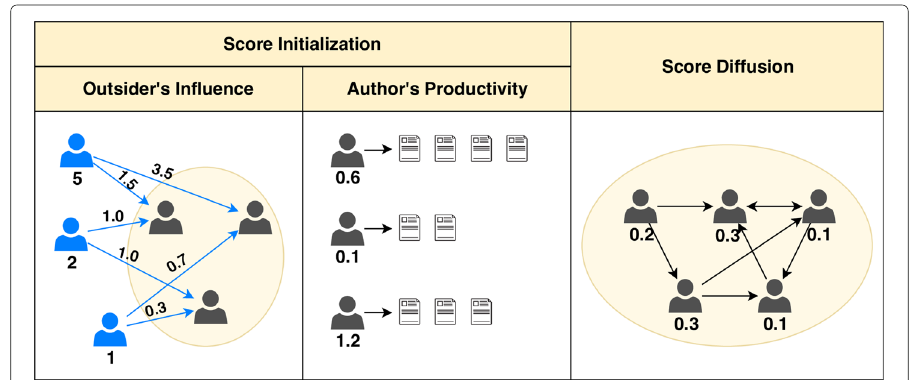
Fig. 3 Illustration of the three different feature categories used in OTARIOS to rank authors are considered better. In order to compare two ranks we use two ranking quality mea- sures: Normalized Discounted Cumulative Gain (NDCG) (Järvelin and Kekäläinen 2002) and Mean Reciprocal Rank (MRR) (Voorhees and et al. 1999). NDCG is a Discounted Cumulative Gain(DCG) based metric which divides the DCG of the predicted rank by the DCG of the ground truth (i.e., the perfect ranking). The idea of DCG is that highly rel- evant authors (from the ground truth) appearing lower in the predicted rank should be penalized using a logarithmic function (base 2) proportional to the position of the result. penalty than placing him in the 10th position. The NDCG value ranges from 0 to 1, where 1 represents the perfect ranking (i.e., the predicted rank is the same as the ground truth one). MRR is the mean ground truth ranking position of a set of the top authors of a ground truth are, on average, ranked more highly by the method. For example, a method that places the 1st, 5th and 6th highest ranked authors from the ground truth in its top-3 authors is better than one that places the 2nd, 6th and 7th highest ranked authors from